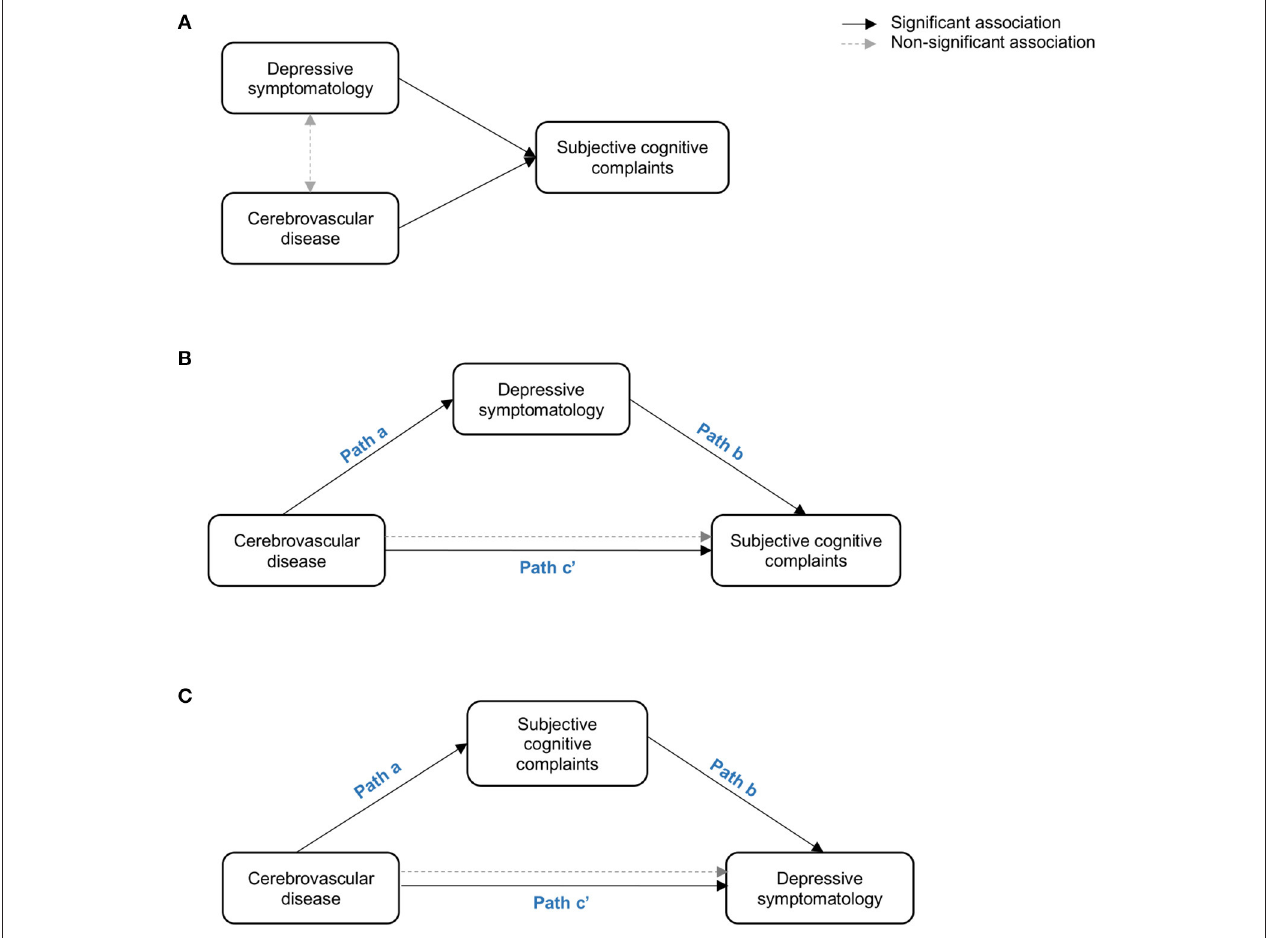
FIGURE 1 | Representation of the three hypothetical scenarios: (A) depressive symptomatology co-exist with SCD (i.e. depressive symptomatology and cerebrovascular disease are independently associated with SCD; (B) depressive symptomatology influeces SCD by mediating the association between cerebrovascular disease and SCD; (C) depressive symptomatology reflects SCD (i.e. SCD mediates the association between cerebrovascular disease and depressive symptomatology. Paths in the figure refer to the associations betwen the independent variable, the mediator, and the dependent variable as described in Baron and Kenny’ mediation framework ( Baron and Kenny,